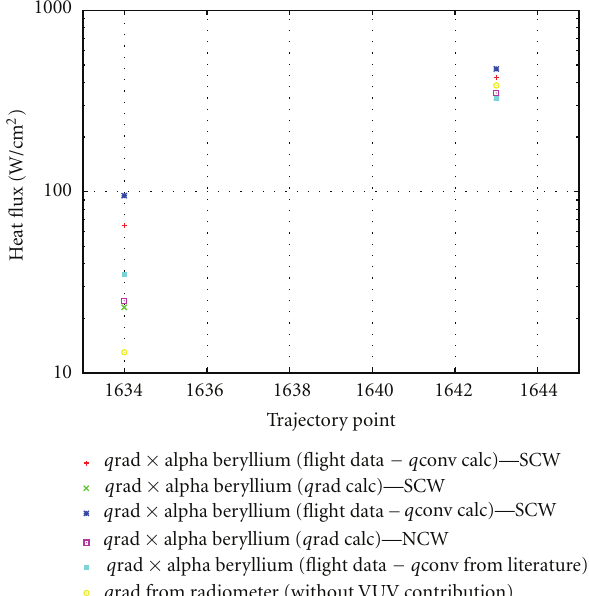
Figure 9: Comparison with flight data for the stagnation